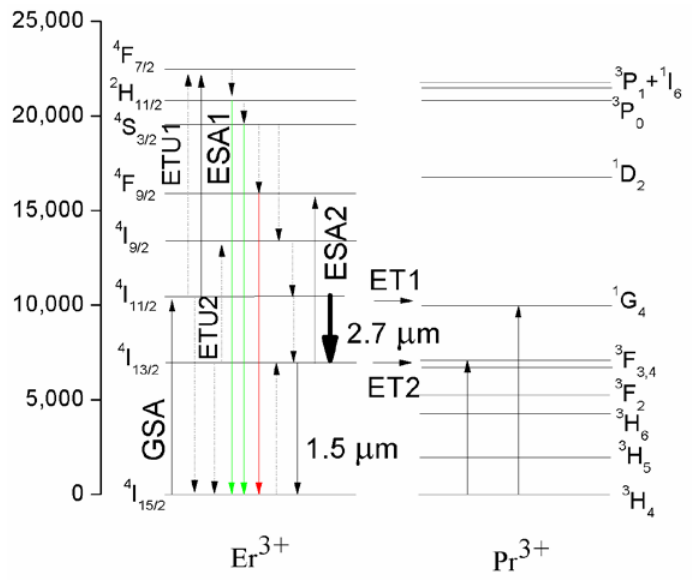
Figure 3. Energy transfer mechanisms of Er 3+ /Pr 3+ codoped glass.